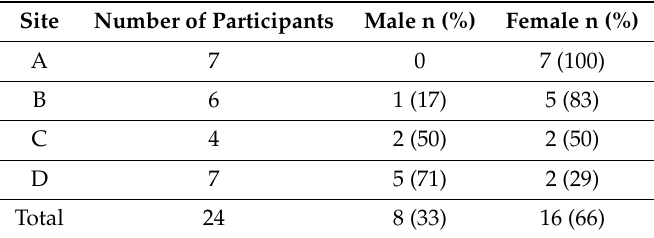
Table 4. Focus group participant numbers and